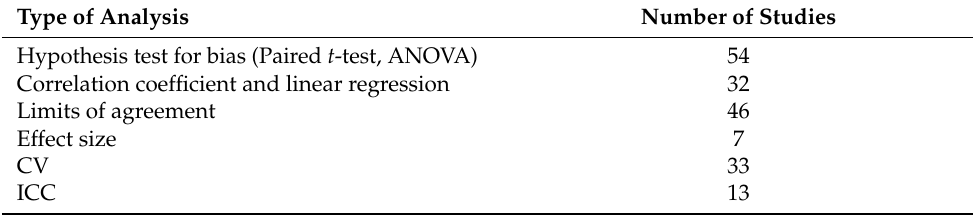
Table 2. The various statistical methods used in validity studies regarding power meters are presented in Table